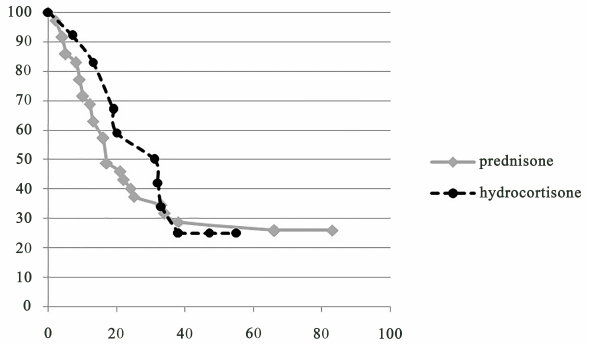
Fig. 2. Overall survival (in months) of patients treated with